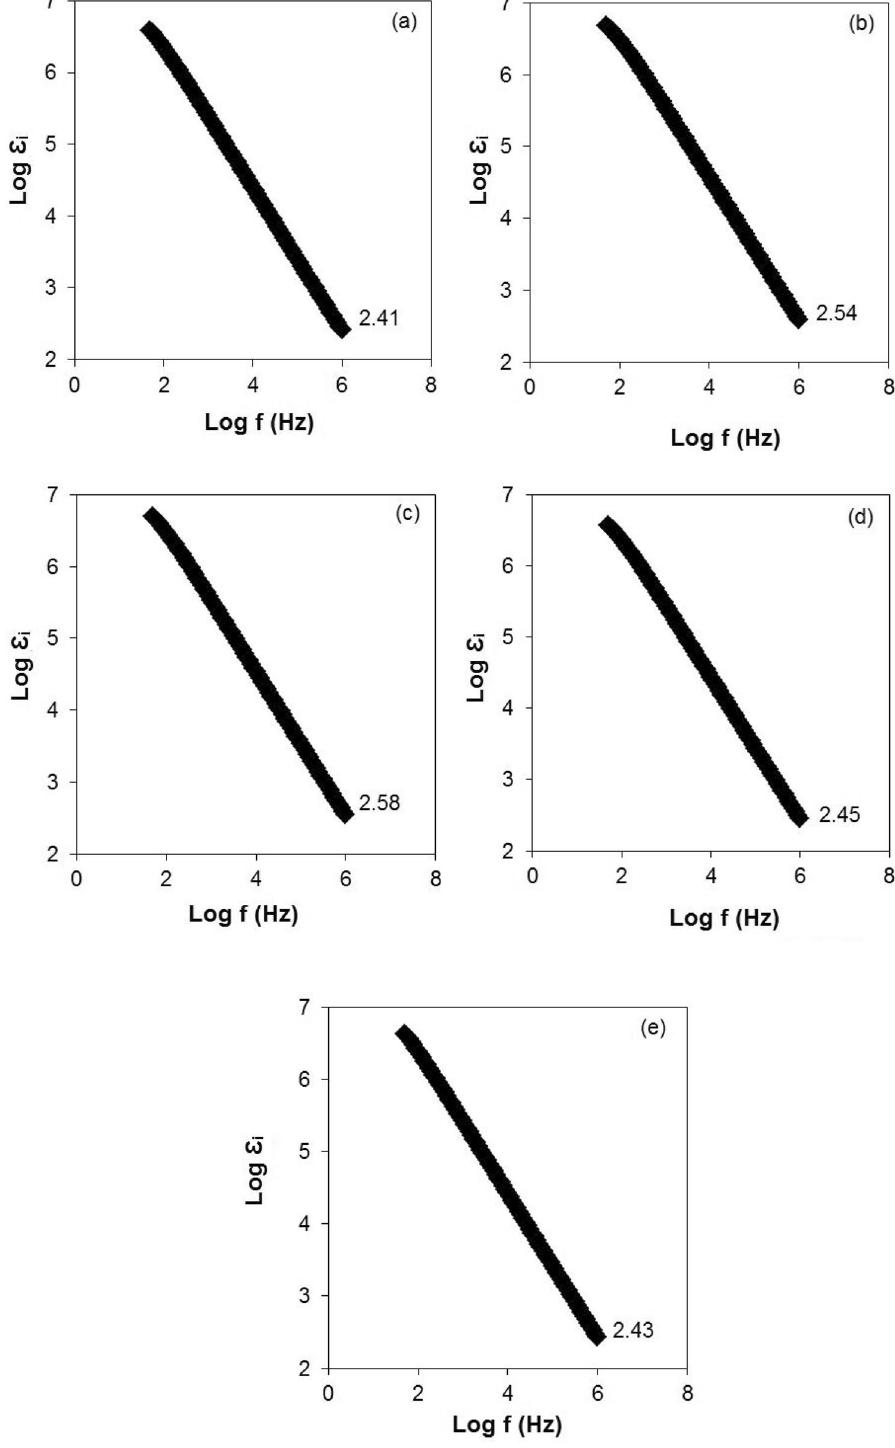
Figure 6. Log ε i (Log dielectric loss) versus log frequency for ( a ) 10 wt%, ( b ) 20 wt%, ( c ) 30 wt%, ( d ) 40 wt% and ( e ) 50 wt% of TBAI